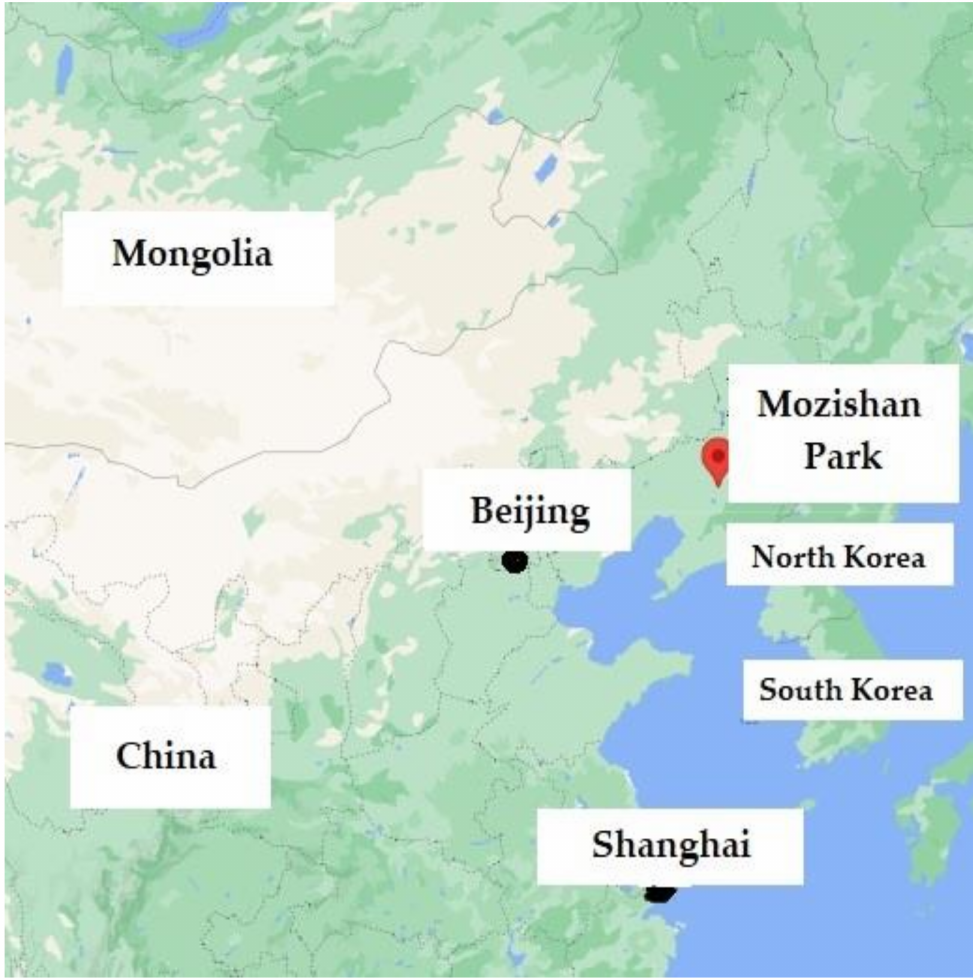
Figure 2. Mozishan Park site area